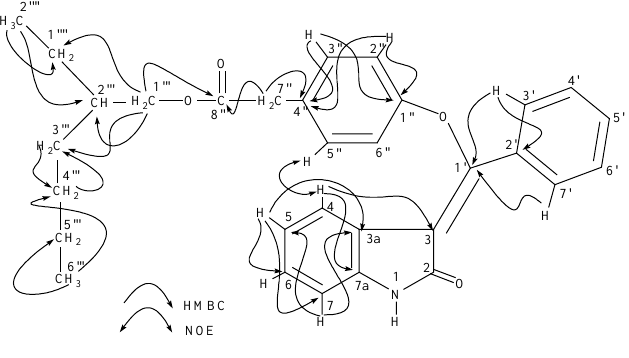
Figure 2 . Inportant HMBC and NoE correlations of isatinone B ( 2 ).